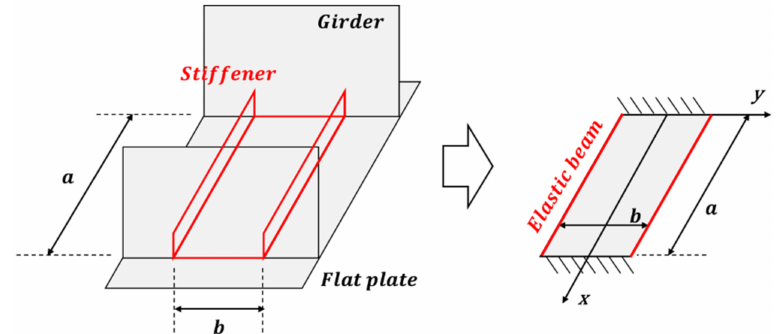
Figure 10. Simple model considering arrangement of the girder and